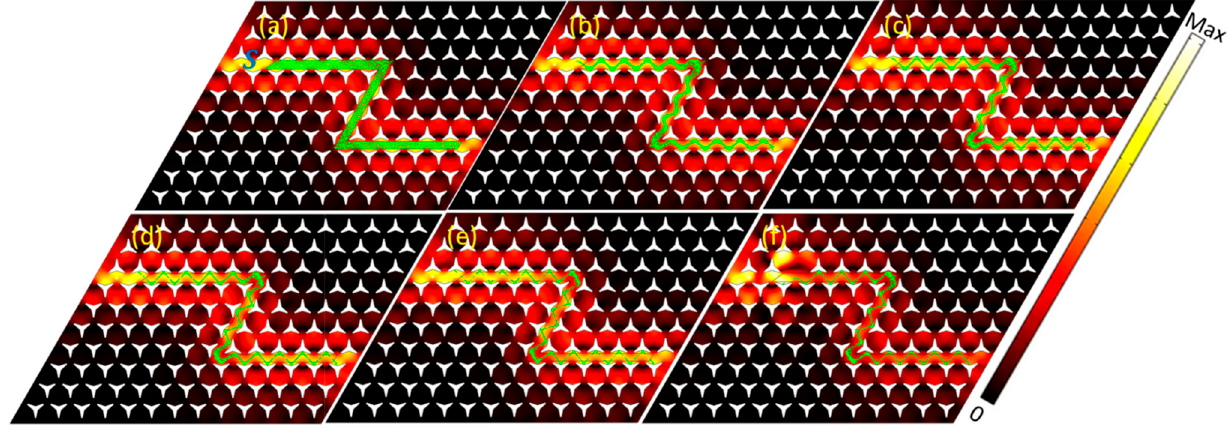
Figure 5. Microparticle distribution at the topologically protected edge states. ( a ) A point source was excited at S with the incident frequency of 66.9 kHz, the green points are the microparticles at initial locations when t = 0 s. ( b – e ) For the case of when t = 1 s, t = 1.5 s, t = 2 s, and t = 3 s. ( f ) For the case of t = 3 s with a defect at the interface of the structures.